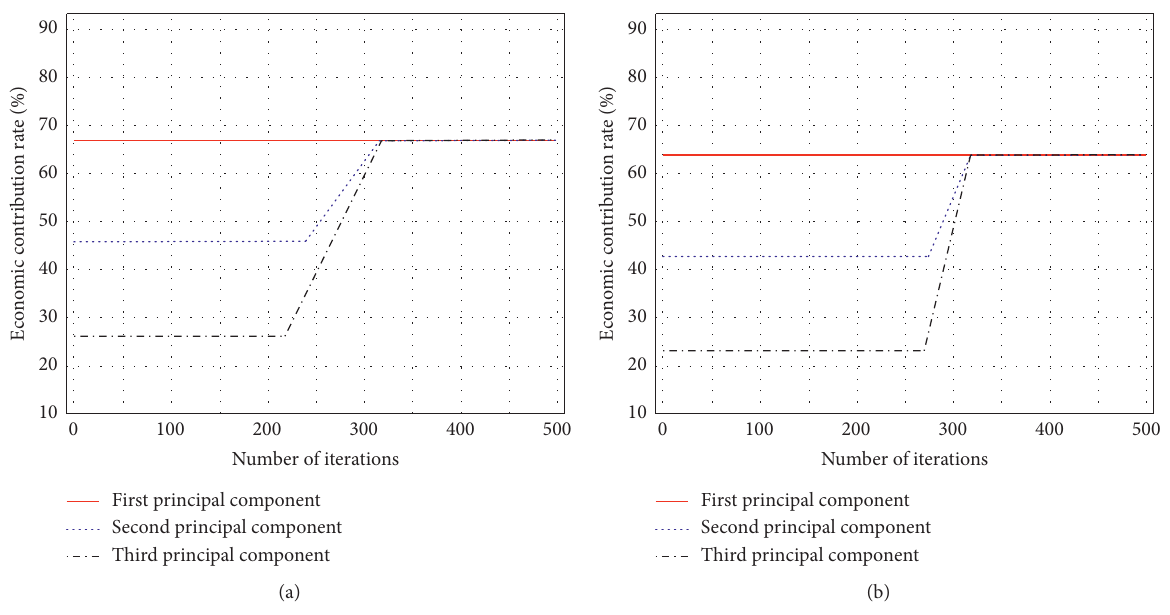
Figure 4: Economic contribution rates of the three principal components with ant colony (a) and genetic (b) algorithm.